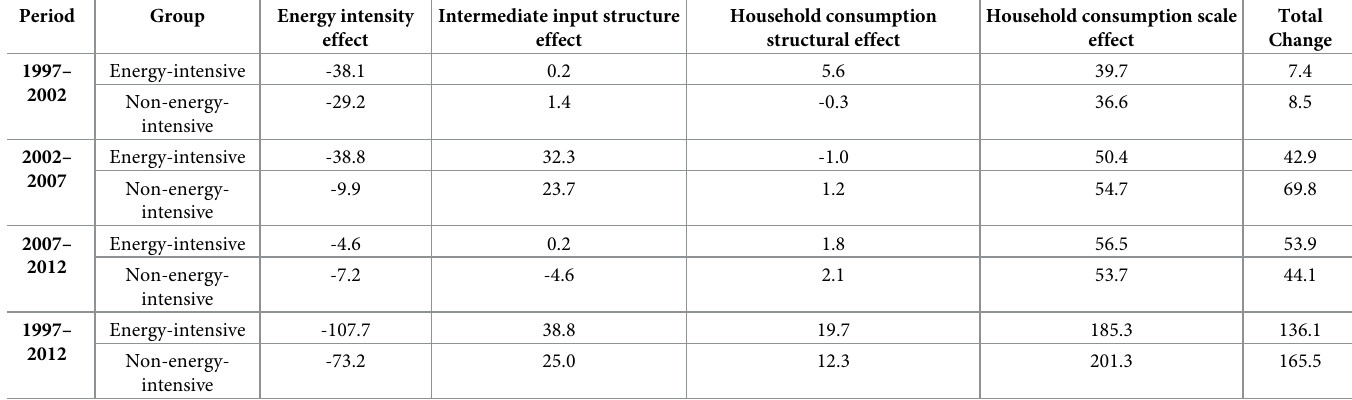
Table 2. The contribution of driving factors to household indirect energy consumption change at the sectoral level between 1997 and 2012 (Unit: %). Period Group